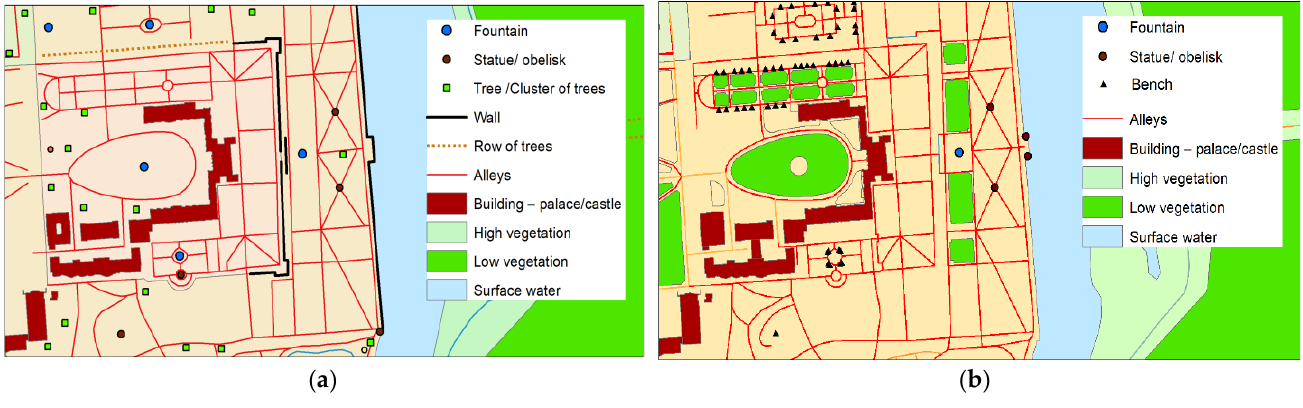
Figure 3. Databases for Wilanow Park: ( a ) BDOT10k; ( b ) OSM. For six BDOT10k objects and seven OSM objects, separate layers were created. They, respectively, represented 22% and almost 26% of all objects (Table 1). Over 53% of OSM objects and 61% of the BDOT10k objects had descriptive attributes that made it possible to identify the target object types or/and their qualitative features. Names were only available for four objects in BDOT10k and six objects in OSM (Figure